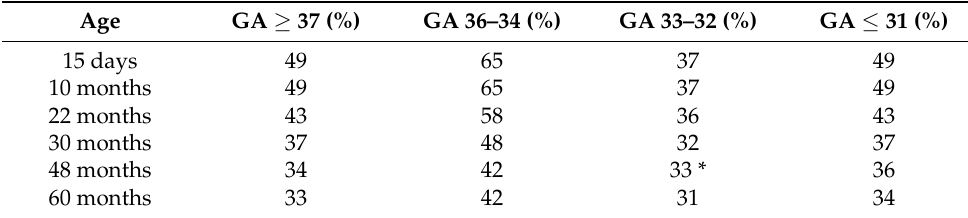
Table 2. Composition of the sample throughout